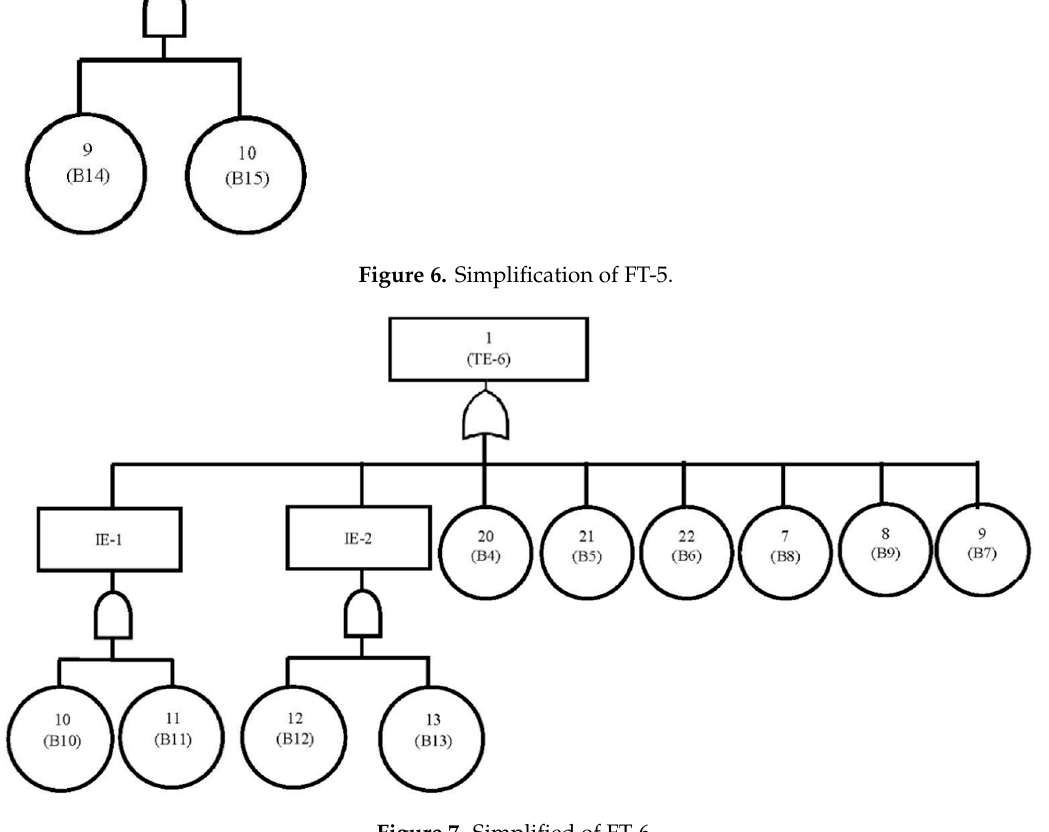
Figure 7. Simplified of FT-6.